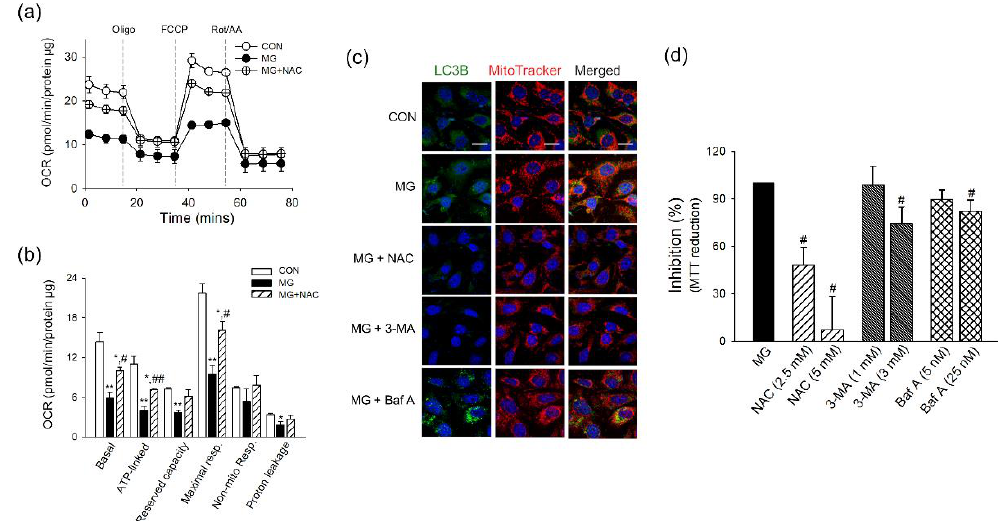
Figure 4. Effects of NAC and autophagy inhibitors on mitochondrial damage induced by MG in brain ECs. ( a , b ) bEnd.3 cells were treated with NAC (5 mM) for 1 h before and during MG stimulation (1000 μM) for 6 h. Cells were applied to Seahorse MitoStress Assay ( n = 3). ( a ) The profile of the oxygen consumption rate was plotted. ( b ) The parameters for mitochondrial respiration were calculated. ( c , d ) NAC or autophagy inhibitors (3-MA or Baf A) were treated for 1 h before MG treatment, and maintained for 6 h during MG treatment. ( c ) The localization of LC3B and mitochondria was examined by confocal microscopy. Mitochondria were labeled by MitoTracker. Representative images are shown. Scale bar: 20 μm. ( d ) The effects of NAC or autophagy inhibitors (3-MA or Baf A) on MG-attenuated MTT reduction were determined ( n = 3~4). Data are presented as the mean ± SEM. * p < 0.05, ** p < 0.01 vs. control (CON). # p < 0.05, ## p < 0.01 vs. MG-treated cells.